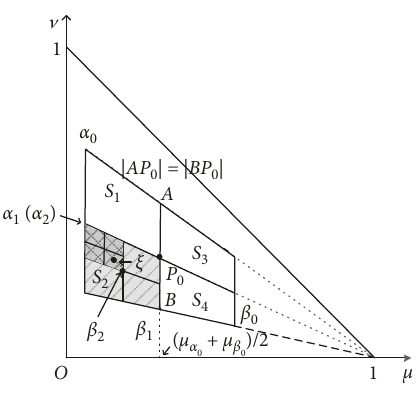
Figure 2: Geometric interpretation of Theorem